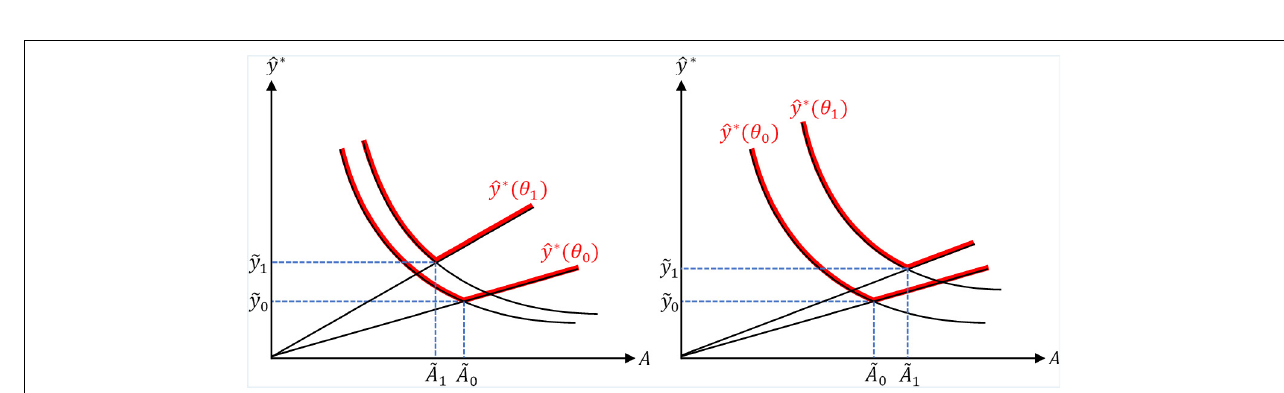
FIGURE 5 | Impacts of technology multiplier